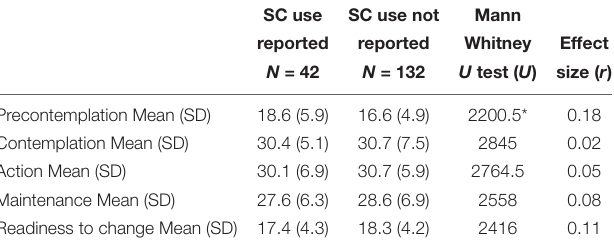
TABLE 5 | Stages of motivation for behavior change in SC and non-SC using OST